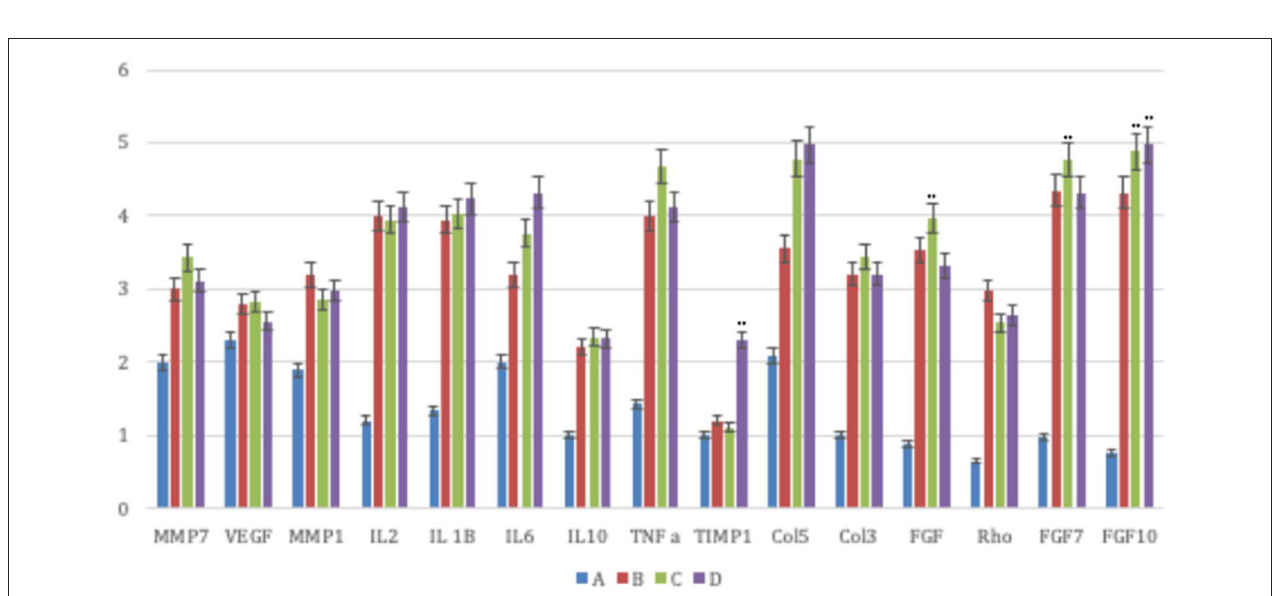
FIGURE 4 | Signs of inflammatory condition in all groups (Group A: control lesions; Group B: 16 mg/ml talc injection; Group C: 160 mg/ml talc injection; Group D: 300 mg/ml talc injection) at 4 weeks: high infiltration of granulocytes, macrophages, polymorphic nuclear cells (PMNs) and non-polymorphic nuclear cells, high fibroblasts and endothelial cells, few elastic fiber, and high collagen fibers were present.